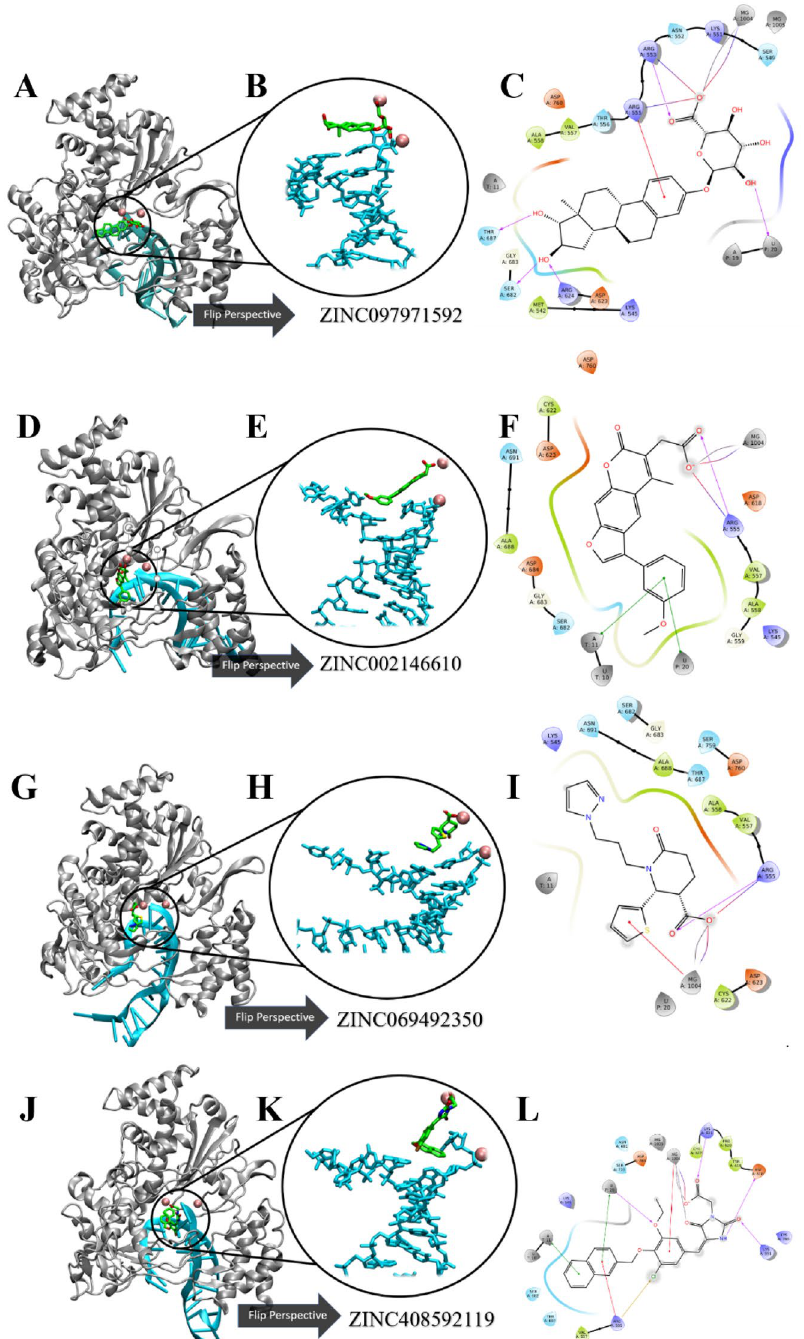
Figure 8. Ligand–receptor interaction diagrams and representations of the most abundant conformational pose from MD simulation. ( A,D,G,J ) The 3D cartoon representation of SARS-CoV-2 RdRp colored in gray. ( B,E,H,K ) Zoomed and rotated perspective of the template-primer RNA in complex with four ZINC candidates. ( C,F,I,L ) Detailed receptor-RNA-ligand contacts of the most abundant conformational pose of four ZINC candidates. Template and primer strands represented in blue and red licorice, respectively. Ligands are colored in green and magnesium ions are represented as pink